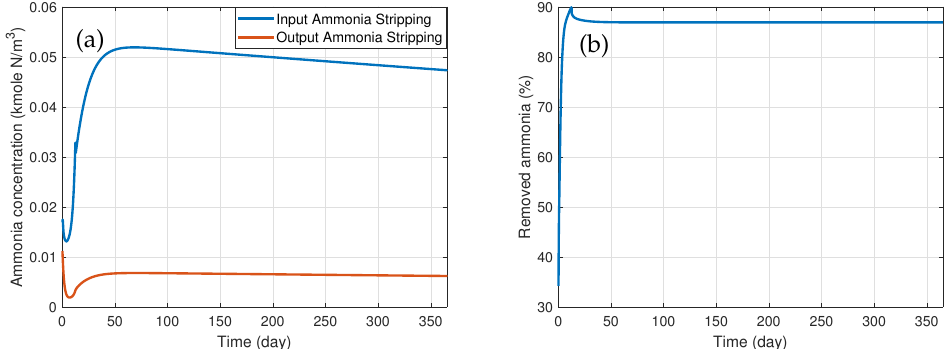
Figure 11. Ammonia stripping: ( a ) Influent and effluent ammonia concentrations. ( b ) Efficiency of the stripping